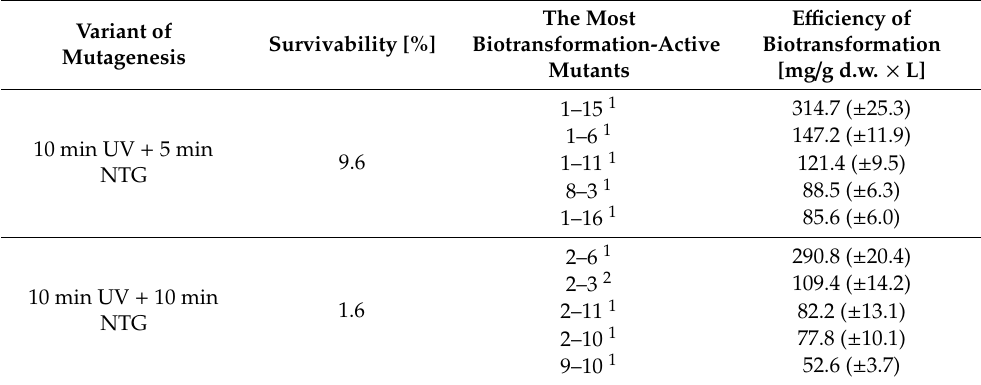
Table 1. Relationship between survivability of conidia obtained using mutagenesis and the e ffi ciency of biotransformation of β -pinene to the main product trans -pinocarveol by mutants of C. pannorum A-1. Variant